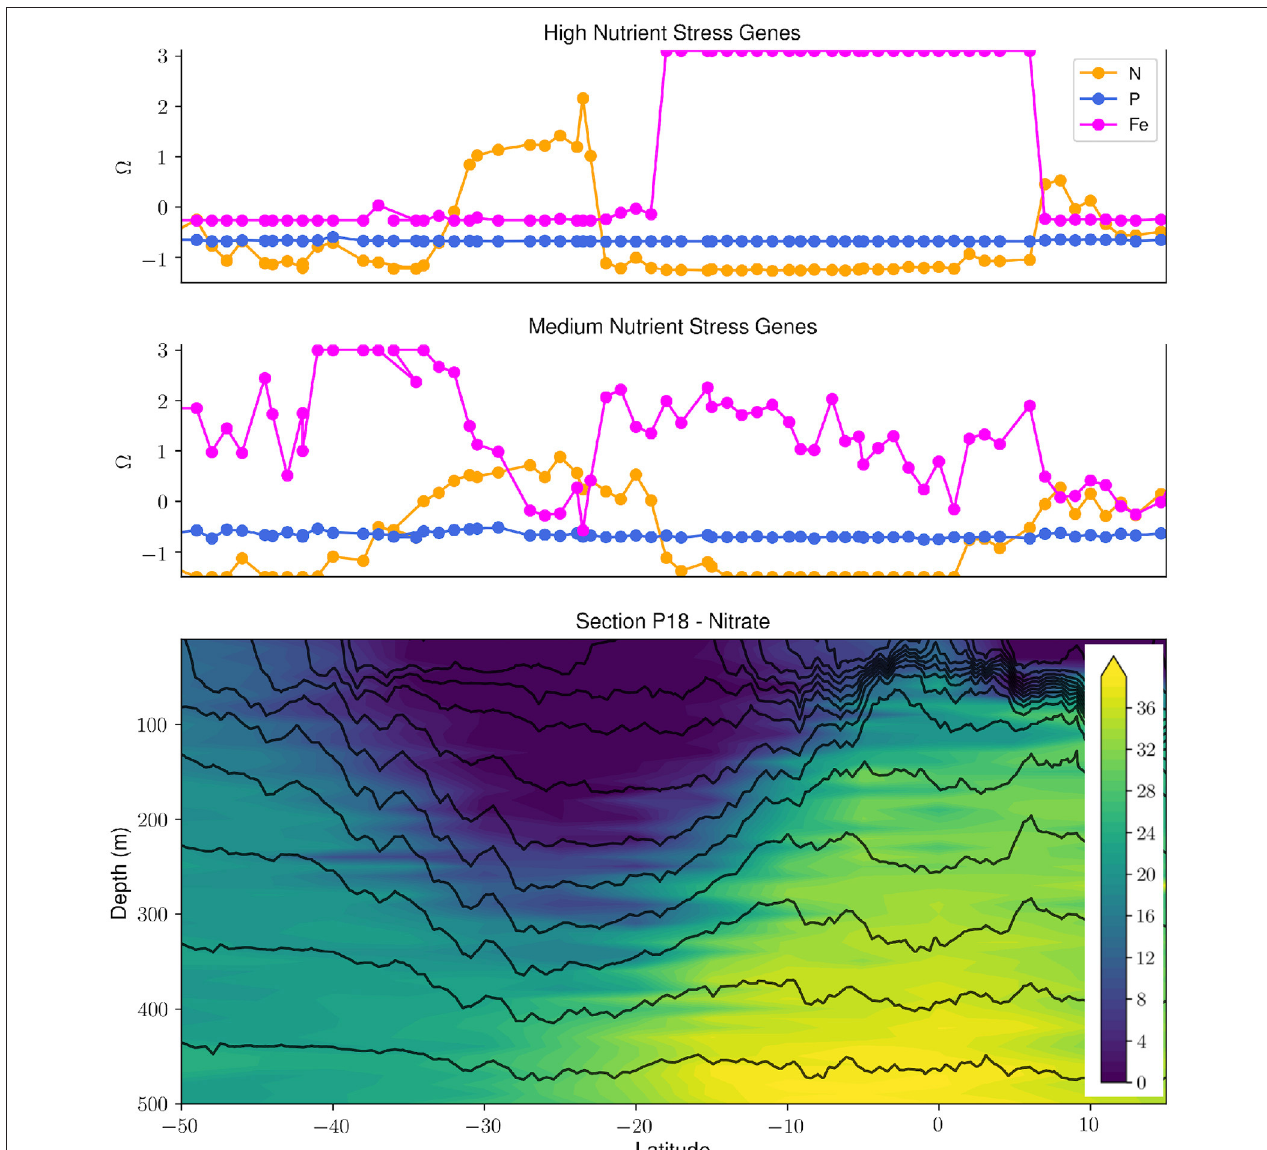
FIGURE 1 | Synergy of biological, hydrographic and chemical data collected during the GO-SHIP P18 repeat section uncovers patterns and drivers of nutrient stress in Prochlorococcus . The upper two panels panel show the high and medium stress composite metrics ( (cid:127) ) for N, Fe, and P (taken from Ustick et al., 2021). The bottom panel shows the nitrate concentration ( µ mol/kg) in the upper 500 m along the P18 transect with density contours (black contour lines). There is a clear relationship between the severity of N stress in Prochlorococcus and the depth of the nitracline. The P18 section is highlighted in red in Figure 2